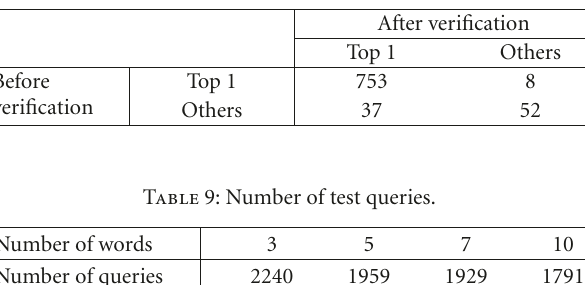
Table 8: Relationship between the rank of the correct hypothesis and verification method.